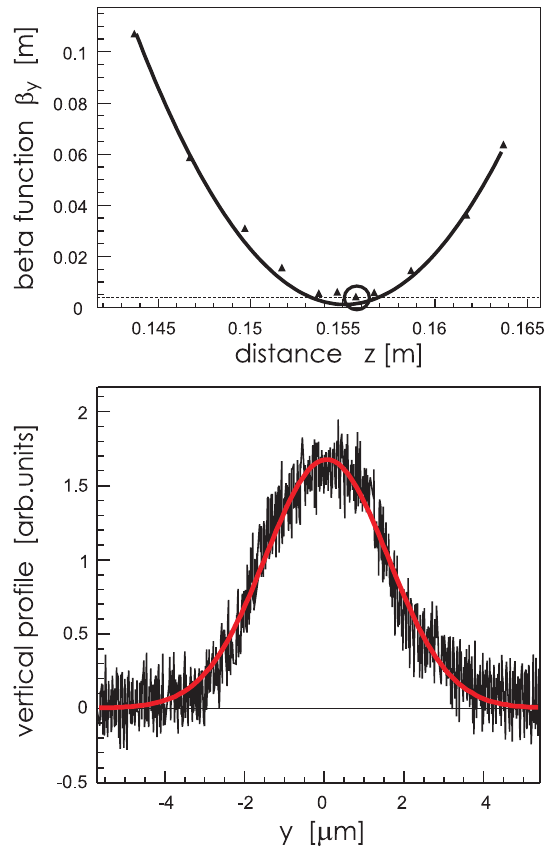
FIG. 11. (Color) Results of the measurement of the imaging properties of a single quadrupole magnet. The triangles in the upper graph depict the measured beta function. The horizontal line indicates the resolution of a single measurement due to the thickness of the wire of 4 (cid:1) m . The lower graph illustrates the resolution limited width measured close to the focal